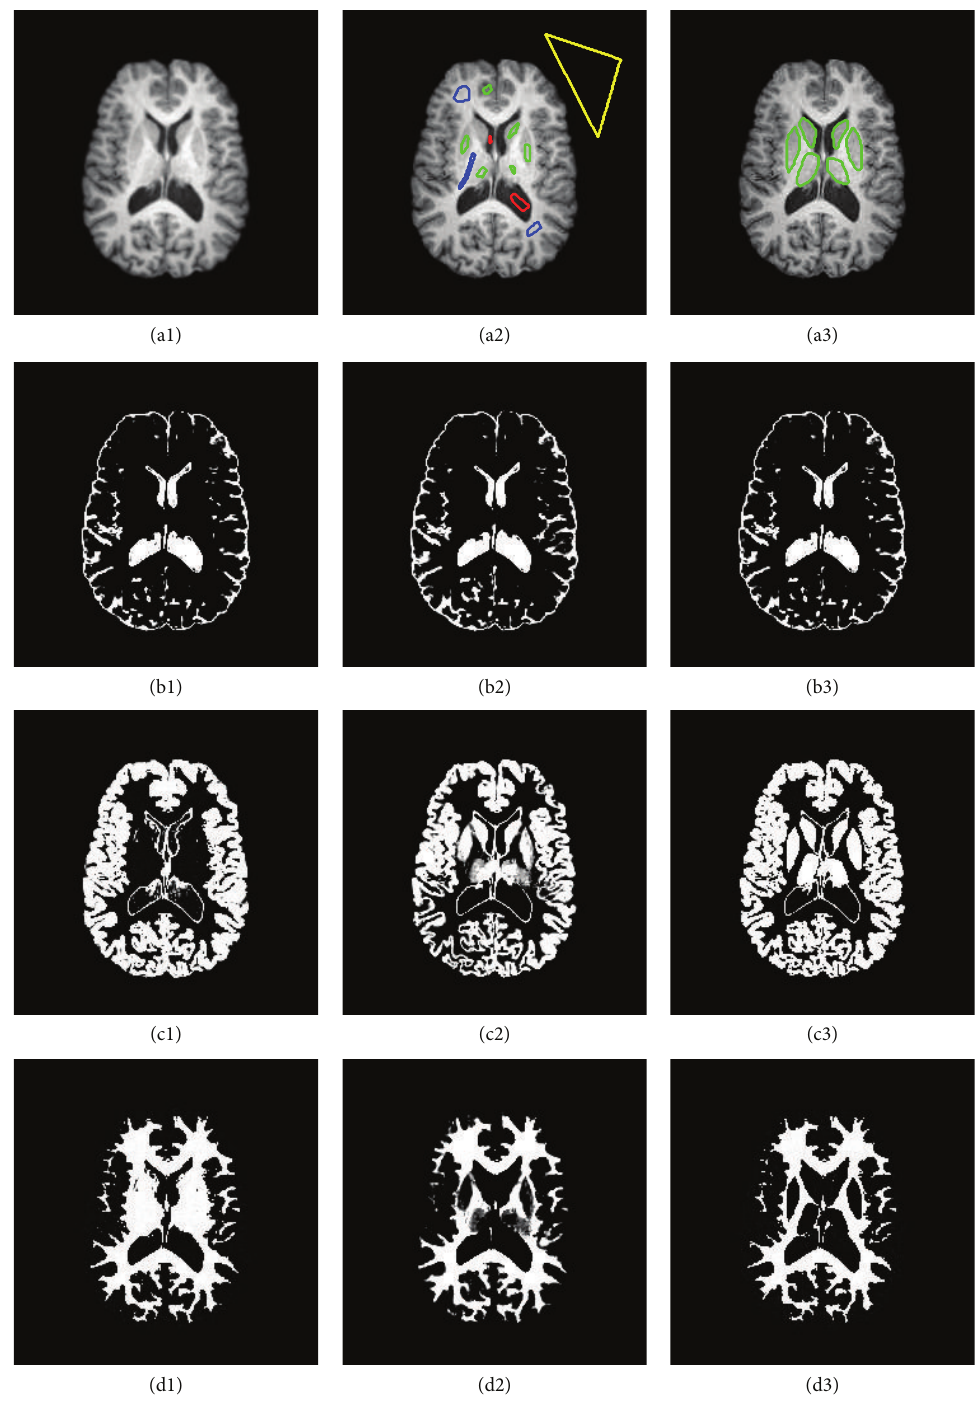
Figure 7: Comparison among unsupervised method, supervised method, and the ground